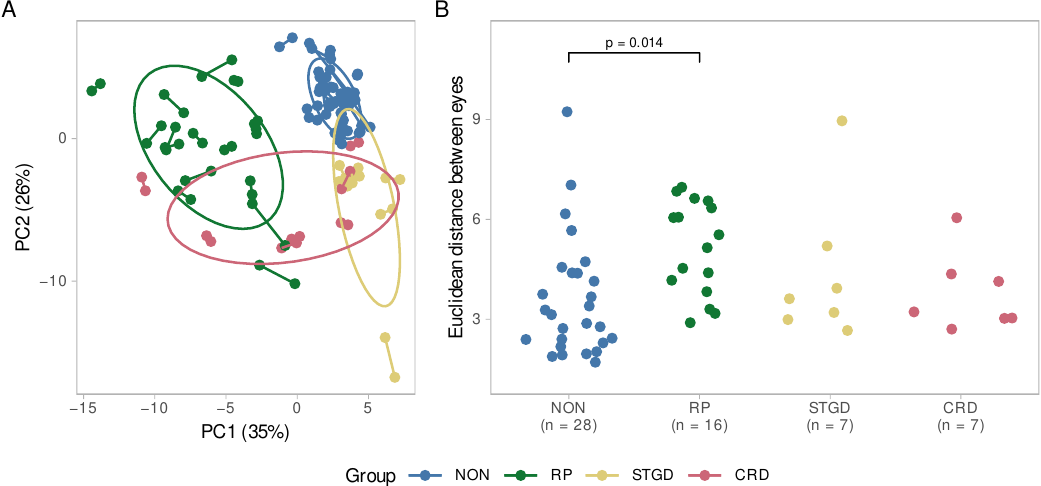
Figure 5. ( A ) Principal component analysis. The difference between both eyes of each patient is displayed. Each eye pair is connected by a line. The greater the distance between two points, the greater is the difference between the eyes of a patient. The ellipses represent the diseases as clusters. The controls (NON) and STGD group seem to be very homogeneously according to their small ellipses and short inter-eye distances. For the CRD group, there is a high interocular symmetry, while the intragroup variability is higher than in controls and STGD. The RP group reveals interocular as well as intragroup heterogeneity; ( B ) Euclidean distance between the eyes of the patients. Here, as well, the RP group shows a wider spread than the other diseases and the control group. The difference is significant compared to the control group ( p = 0.014). NON = Controls, STGD = Stargardt disease, RP = Retinitis pigmentosa, CRD = cone–rod